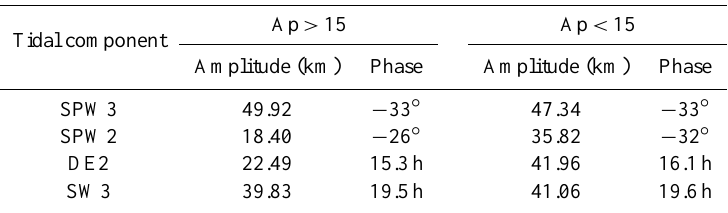
Table 5. Amplitudes and phases for the most prominent tidal components contributing to the modulation of ApexHC during the months around December solstice for magnetic quiet and disturbance